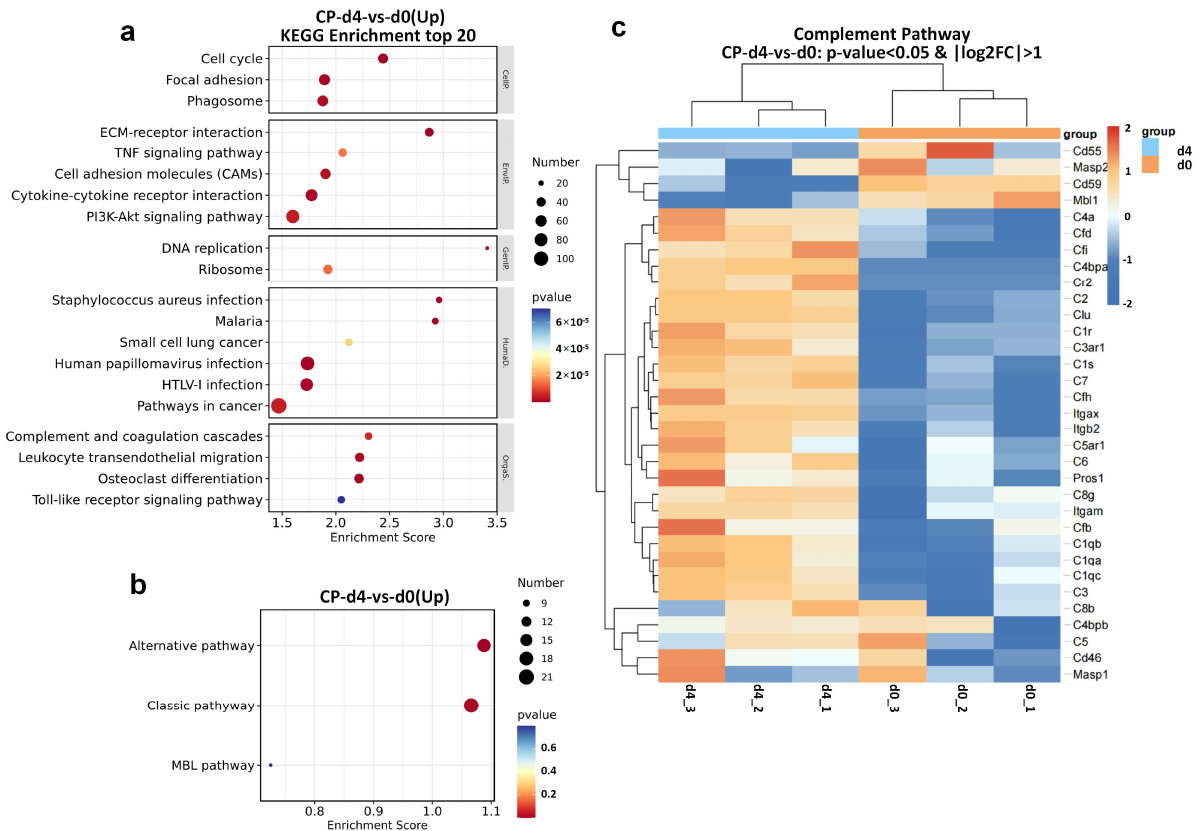
Figure 3. Transcriptomic analysis of kidneys from SD rats before and 4 days after the first cisplatin (CP) injection. ( a ) The top 20 enriched KEGG pathways of significant DEGs (total). ( b ) The enrichment of three complement activation pathways of significant DEGs (up). ( c ) Heatmap showing the complement-pathway-related DEGs differentially expressed across the two groups, n = 3. KEGG, Kyoto Encyclopedia of Genes and Genomes; DEGs, differentially expressed genes; Clu, clusterin; Itgax, integrin subunit alpha X; Itgb2, integrin subunit beta 2; Pros1, protein S (alpha).